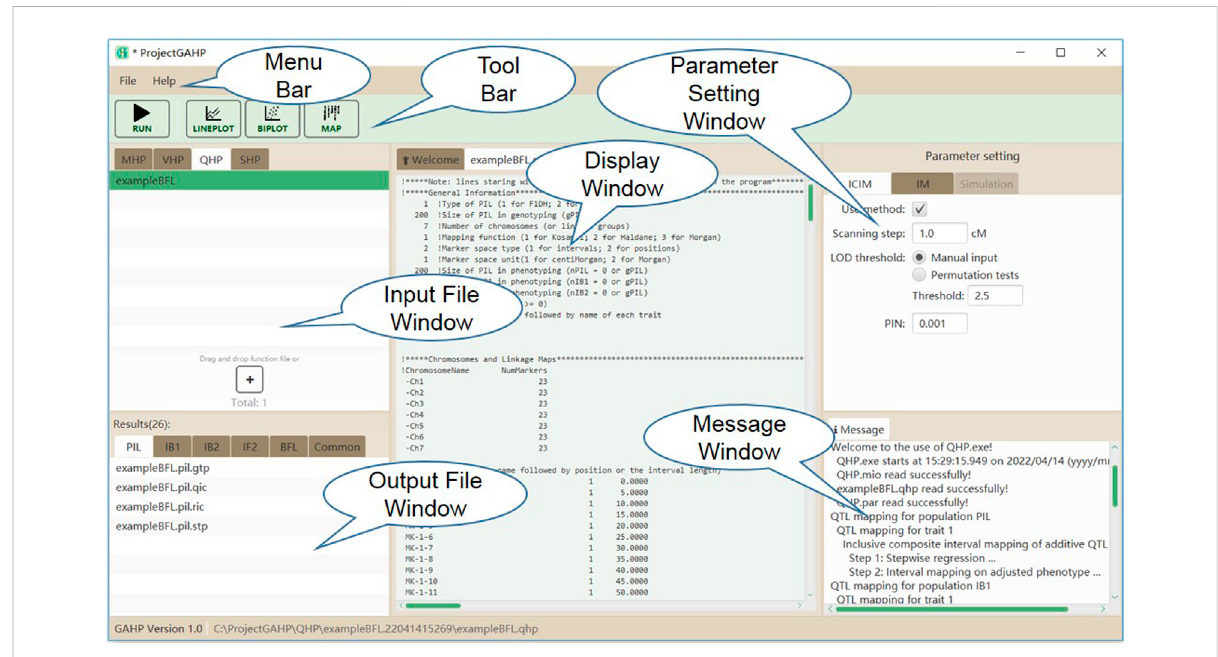
FIGURE 4 The interface of functionality